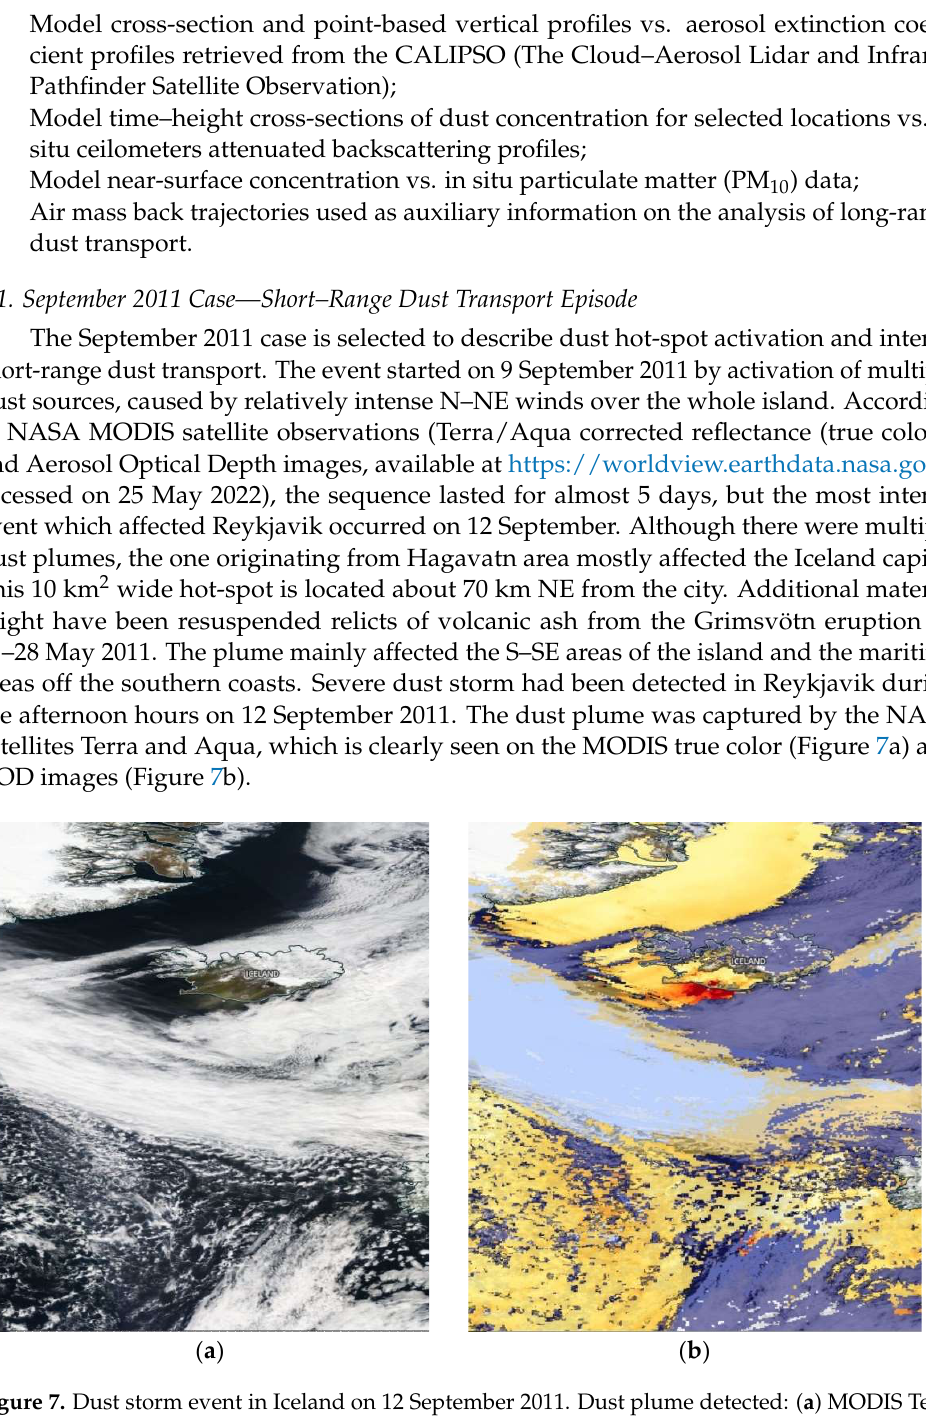
there are usually no other PM sources activated in this period of the year.